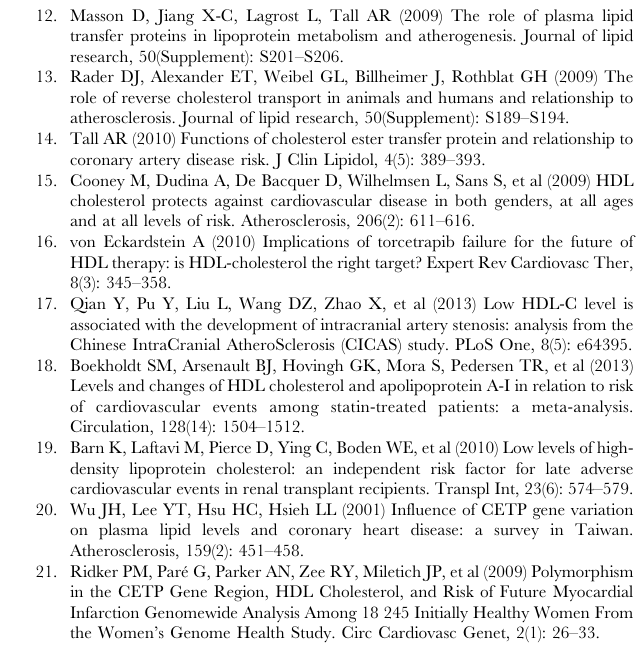
Heterogeneity factors